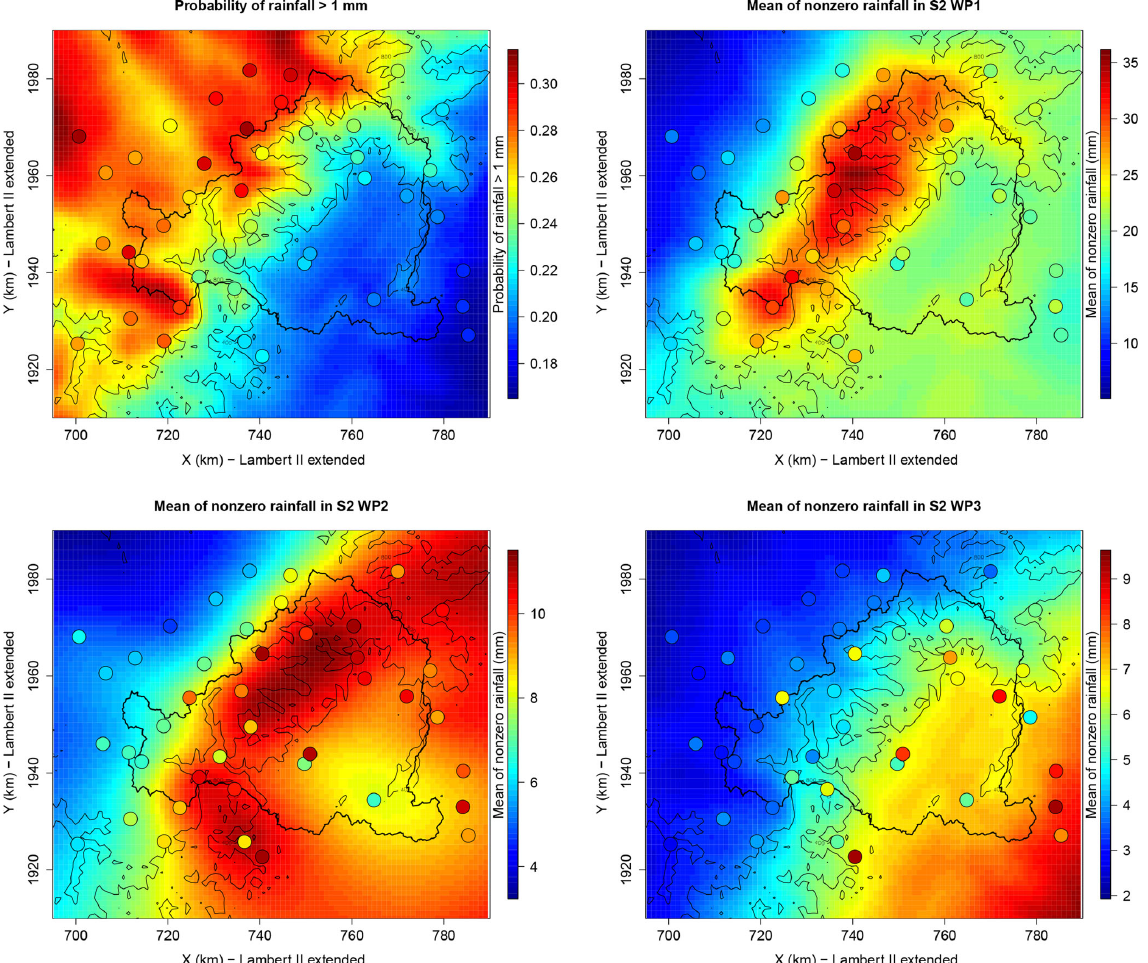
Figure 12. Map of the probability of daily rainfall exceeding 1mm and of the mean of nonzero rainfall in the three WPs of the season-at-risk. The points are colored with respect to the empirical